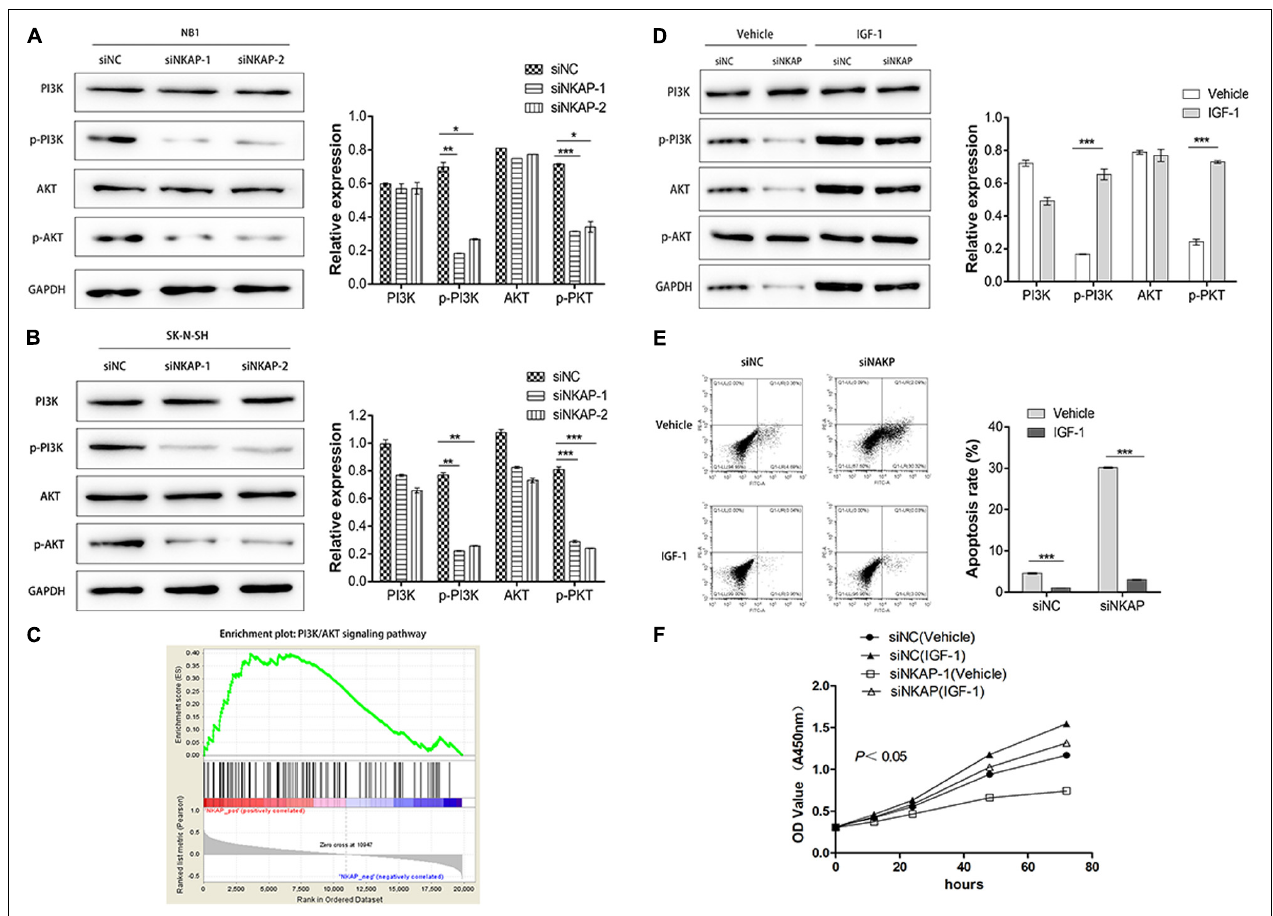
FIGURE 5 | NKAP specific function in neuroblastoma cells via activated PI3K/AKT pathway. Transfected with siNKAP significantly reduced the phosphorylations of PI3K and AKT in NB1 (A) and SK-N-SH (B) cells in vitro . (C) Gene Set Enrichment Analysis. Activation of the PI3K/AKT pathway transfected with siNKAP did not reduce the expression of p-PI3K and p-AKT in SK-N-SH cells (D) , transfected with siNKAP did not promote the apoptosis of SK-N-SH cells (E) , and transfected with siNKAP did not inhibit the proliferation of SK-N-SH cells (F) . *** P < 0.001, ** P < 0.01, * P <